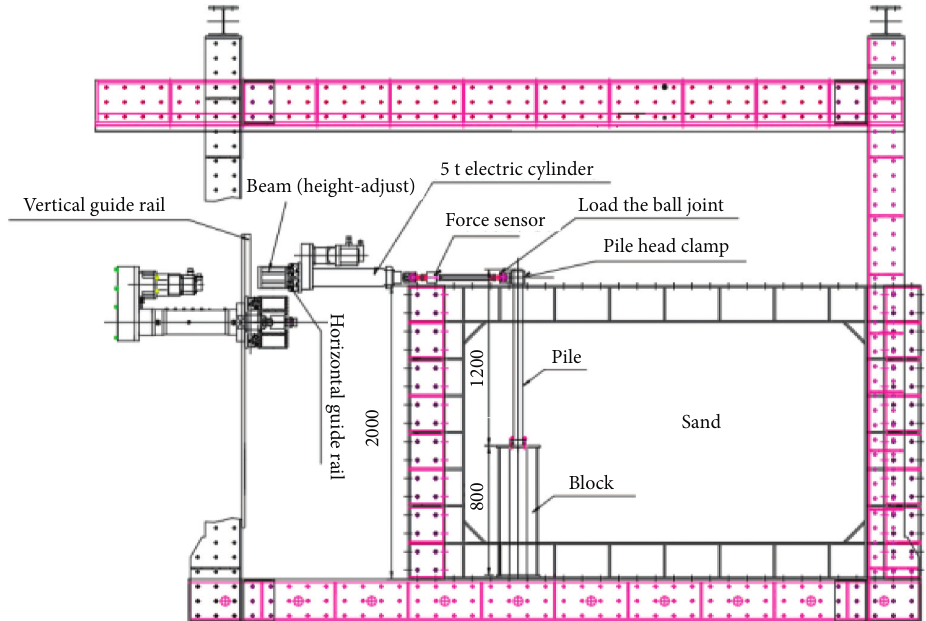
Figure 1: Horizontal loading device.